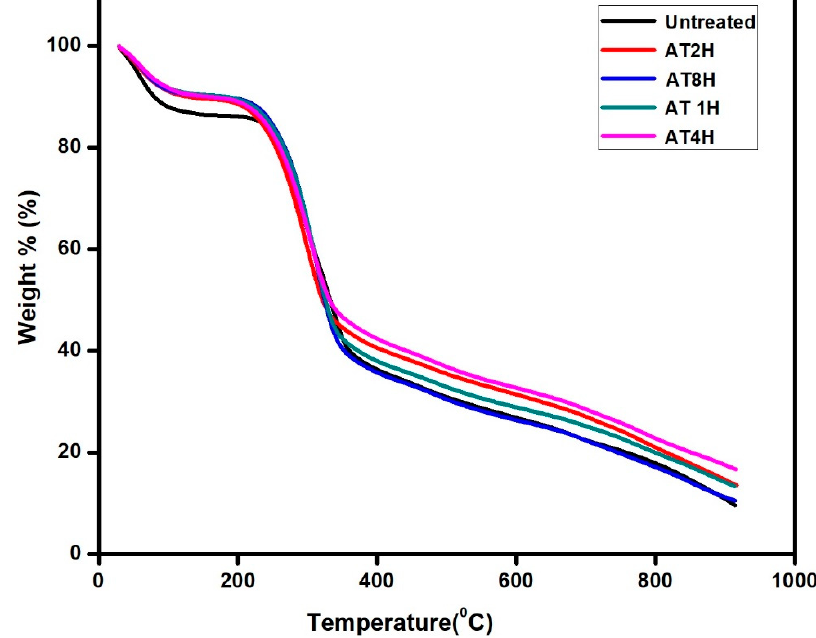
Figure 8. TGA curves of untreated and treated Typha fiber reinforced epoxy composites.